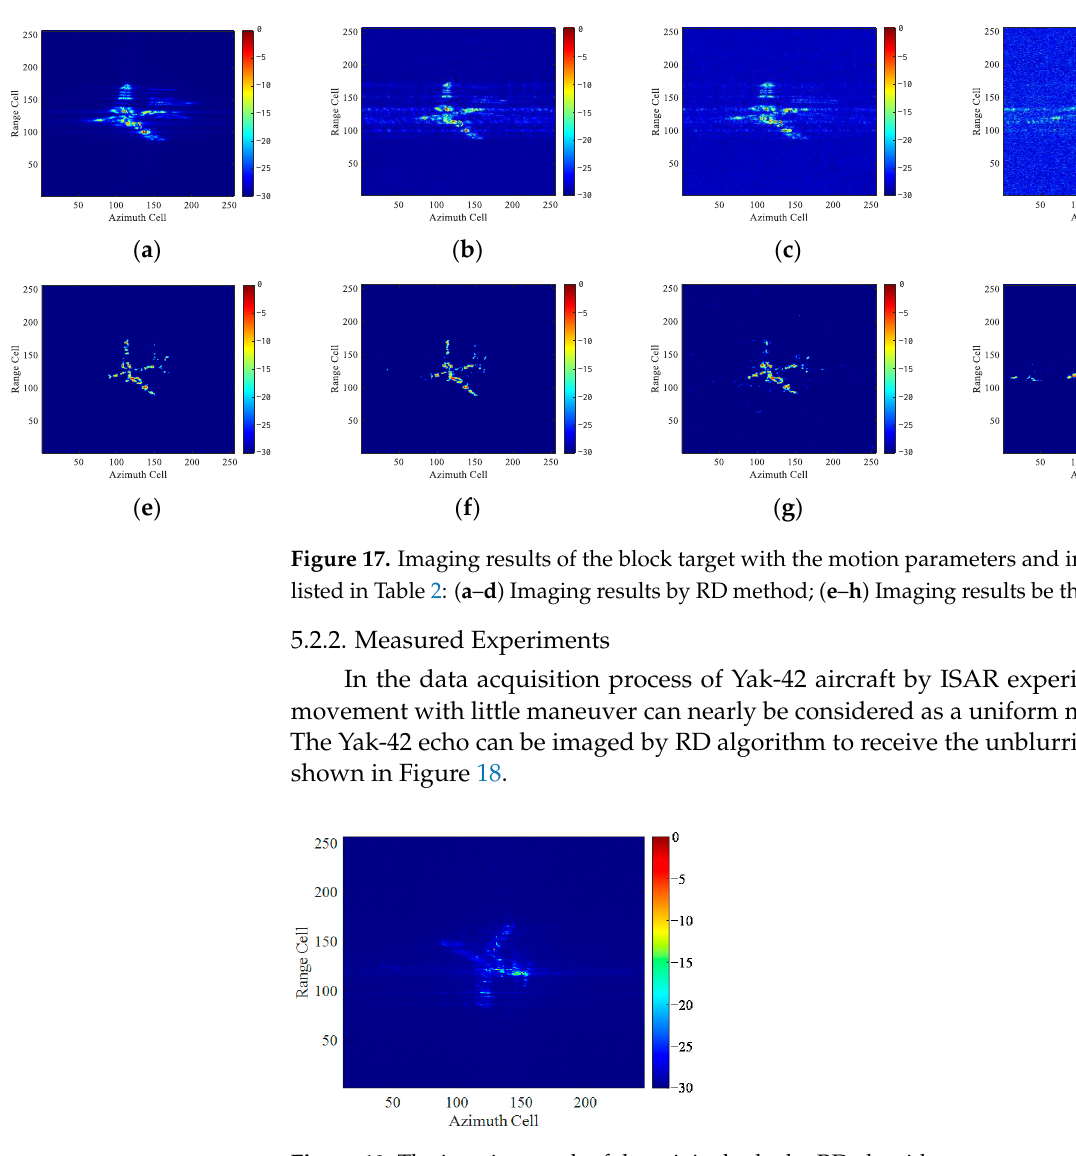
Figure 18. The imaging result of the original echo by RD algorithm.